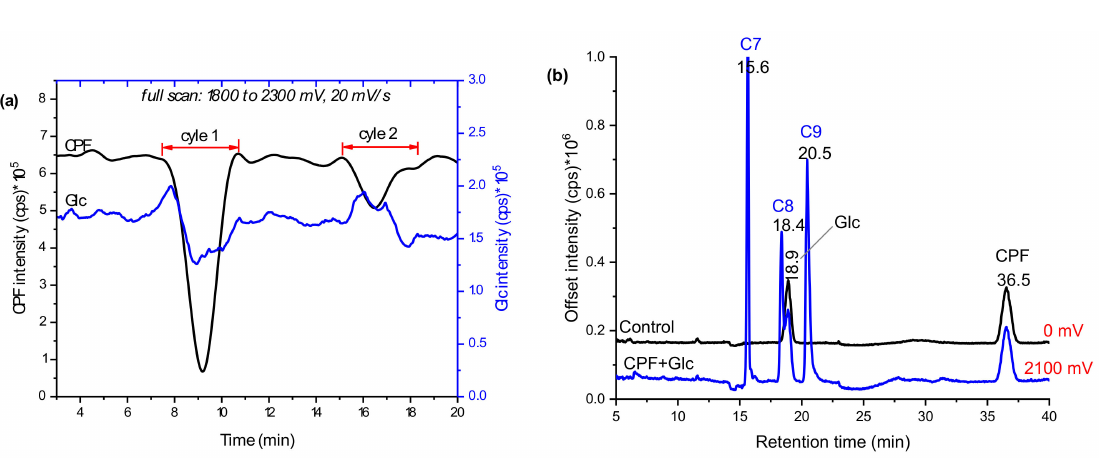
Figure 5. Mass voltammograms of CPF oxidative products and Glc after scanning in 1800–2100 mV using EC/MS equipped with BDD WE ( a ) and EIC chromatograms with and without applied potentials measured by LC-MS/MS ( b ).